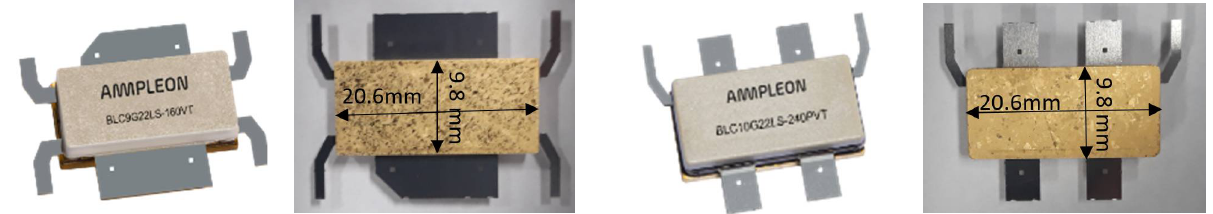
Figure 1. Cases of the investigated RF power transistors and their dimensions.